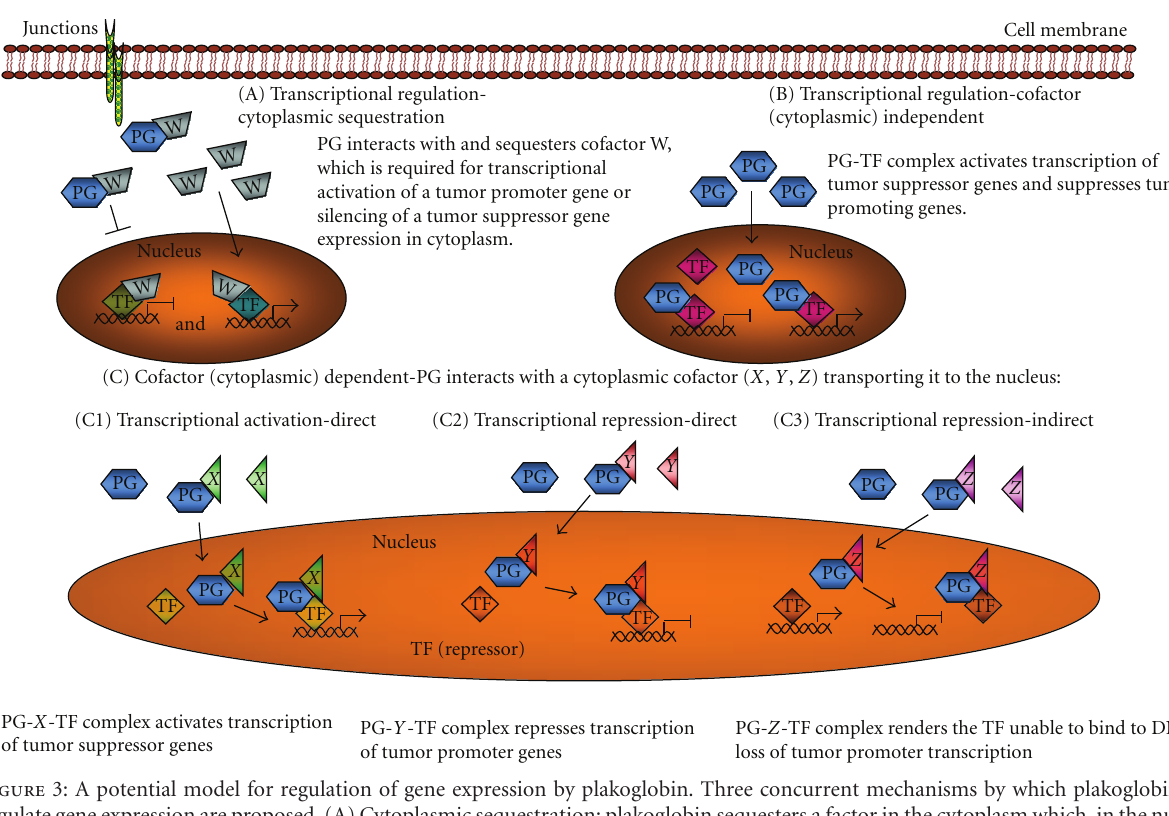
Figure 3: A potential model for regulation of gene expression by plakoglobin. Three concurrent mechanisms by which plakoglobin may regulate gene expression are proposed. (A) Cytoplasmic sequestration: plakoglobin sequesters a factor in the cytoplasm which, in the nucleus, suppresses the expression of a tumor suppressor gene or activates the expression of an oncogene. (B) Cytoplasmic cofactor independent: plakoglobin-transcription factor complexes promote the expression of tumor suppressor genes and repress the expression of oncogenes. (C) Cytoplasmic cofactor dependent: plakoglobin interacts with a cytoplasmic cofactor and this complex moves into the nucleus where it activates tumor suppressor gene expression or represses oncogenic gene expression. PG: plakoglobin; TF: transcription